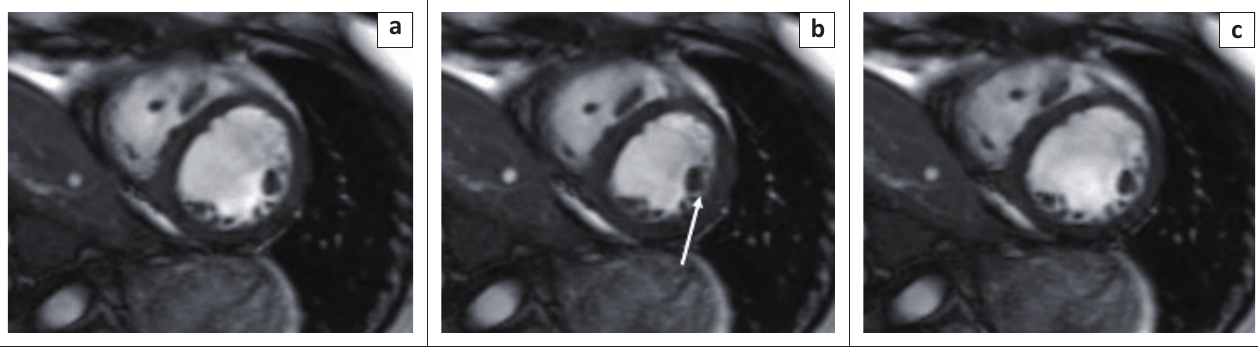
FIGURE 3: Three short-axis cine SSFP images of the LV at the phases (a, b and c) close to end-systole. When selecting the end-systolic and end-diastolic phases, it is advisable to observe the relationship of the LV wall to the papillary muscles. When the myocardium is closest to the papillary muscle (white arrow), just before it starts moving away from the LV wall again, is the end-systolic phase. When the lateral wall is furthest away from the papillary muscles, just before it starts moving towards the LV wall again, that is the end-diastolic phase. For video footage, visit: